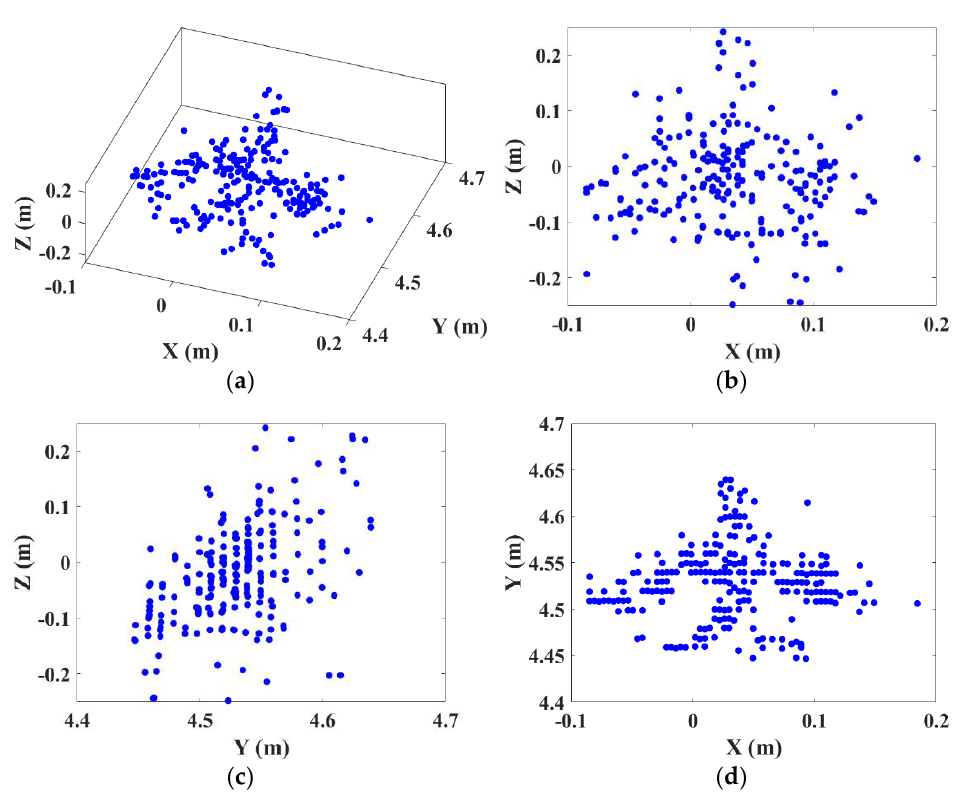
Figure 11. InISAR imaging results of the plane model. ( a ) The 3D view, ( b ) the front view, ( c ) the side view, and ( d ) the bird view.